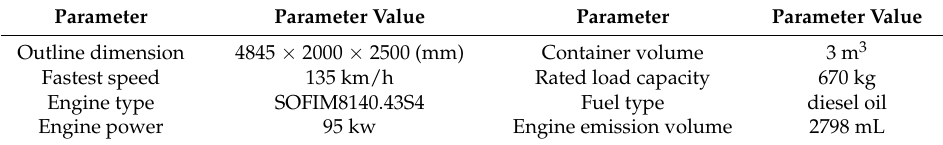
Table 3. Vehicle